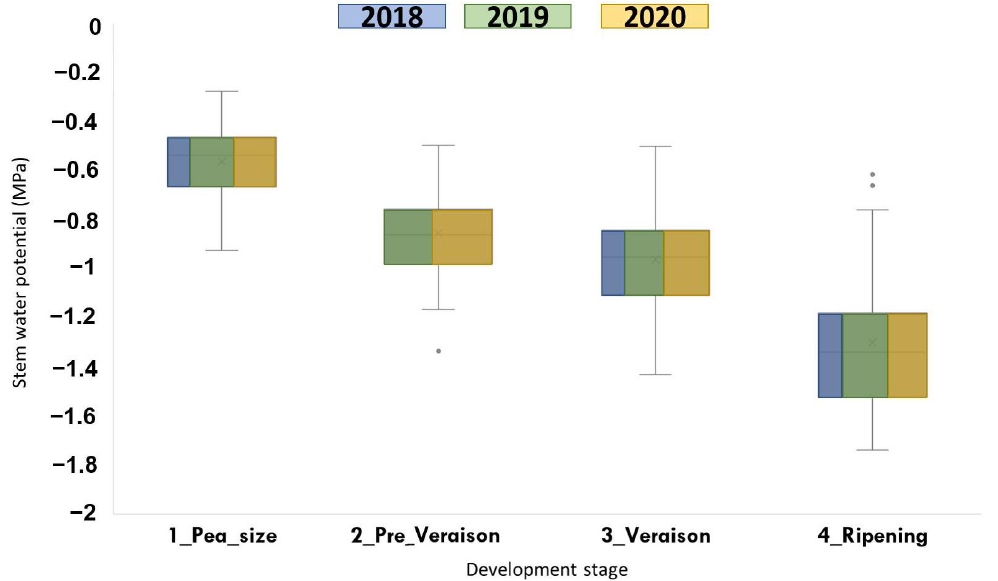
Figure 8. Box plot of SWP values (in MegaPascal) measured in field for each development stage covered by our study. The size of the colored rectangles indicates the percentage of data per year.